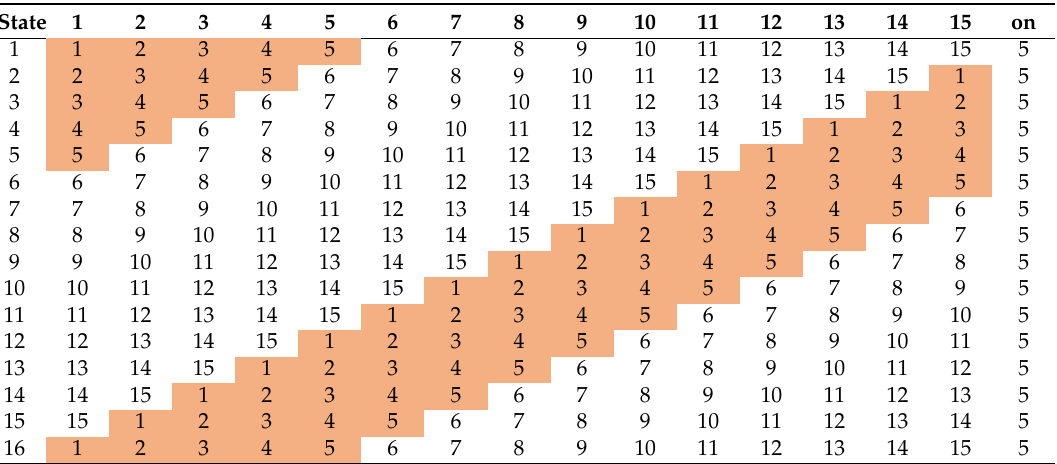
Figure 2. Load operation state diagram. Table 1. Fifteen groups of load temperature state distributions.